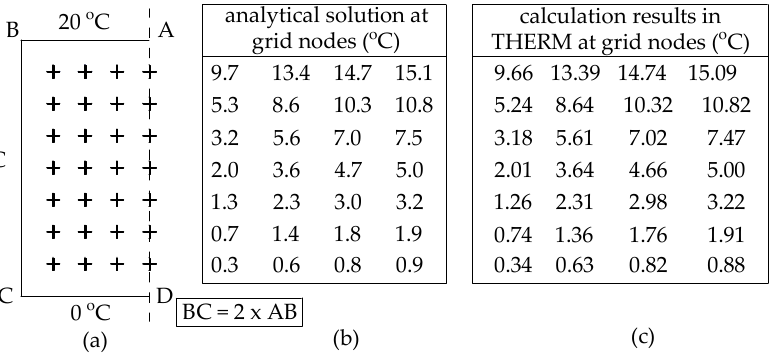
Figure 10. ( a ) Geometry and boundary conditions for test case 1 of Annex C PN ‐ EN ISO 10211:2011, ( b ) Analytical solution at grid nodes for test case 1 of Annex C PN ‐ EN ISO 10211:2011, ( c ) Calculation results in THERM at analyzed grid nodes.